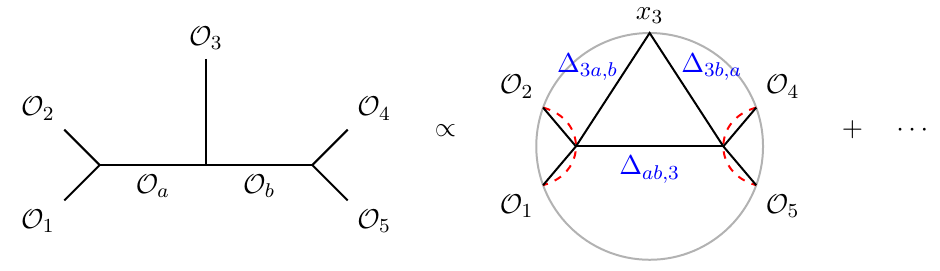
Figure 1. Graphical representation of the scalar (cid:12)ve-point conformal block, W (cid:1) 1 ;:::; (cid:1) 5 and the leading term in its holographic representation (RHS). All solid lines in the bulk diagram on the RHS are bulk-to-bulk or bulk-to-boundary propagators, with the two bulk vertices integrated over boundary anchored geodesics (red dashed curves) and the conformal dimensions associated with some of the propagators explicitly displayed in blue (which makes use of the shorthand (1.5)). The ellipsis represents contribution from the exchange of descendants in the conformal multiplet of primaries O a and O b . The precise relation, obtained in ref. [70], can be found in